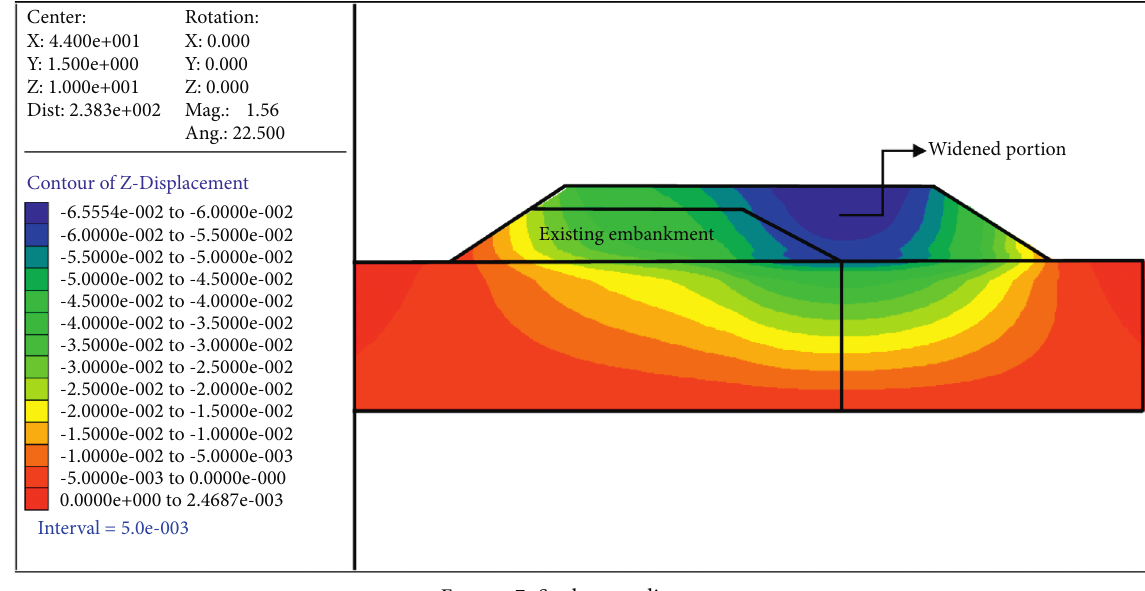
Figure 7: Settlement diagram.